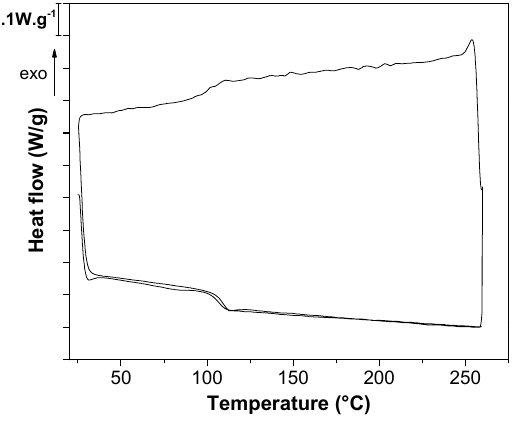
Figure 7. Representative DSC thermogram of CNT6 nanocomposite filament.